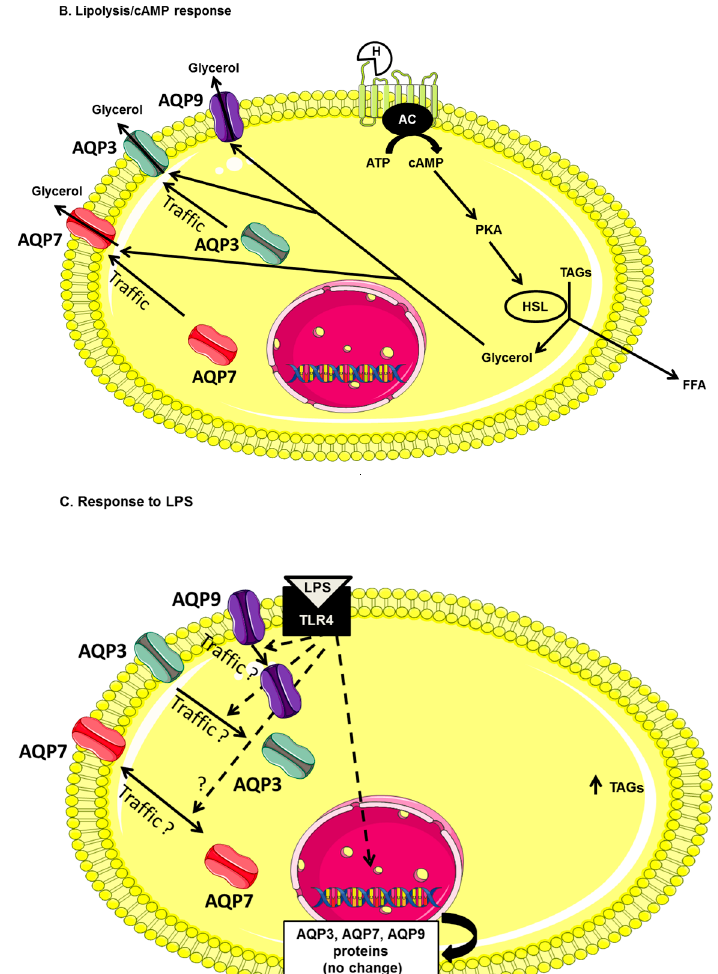
Figure 6. Model for the role of aquaglyceroporins in the regulation of lipogenesis and lipolysis in mouse adipocytes. ( A ) Lipogenesis: insulin is secreted in response to an increase of glycaemia consecutive to feeding. Glucose metabolites, glycerol-3 phosphate (G-3-P) and free fatty acids are used to produce TAGs that will be stored. Both AQP3 and AQP7 are internalized. AQP9 is constitutively expressed at the plasma membrane; ( B ) Lipolysis: upon glucagon secretion in response to fasting or cAMP-mediated response (exercise, catecholamine secretion), TAGs are hydrolyzed to glycerol and free fatty acids, both AQP7 and AQP3 traffic to the plasma membrane enabling increased glycerol efflux. AQP9 may also participate to glycerol efflux during lipolysis. Arrows inside AQP channels represent the direction of glycerol flow; ( C ) Under inflammatory conditions mimicking obesity, LPS is hypothesized to induce AQP3 and AQP9 internalization, thereby reducing plasma membrane glycerol permeability and intracellular TAGs accumulation. Abbreviations: TAGs, triacylglycerols; G-3-P, glycerol-3-phosphate; FFA, free fatty acids; H, catecholamine or glucagon; AC, adenylyl cyclase; ATP, adenosine triphosphate; cAMP, cyclic adenosine monophosphate; PKA, protein kinase A; HSL, hormone sensitive lipase; LPS, lipopolysaccharide; TLR4, Toll-like receptor 4; AQP, aquaporin.